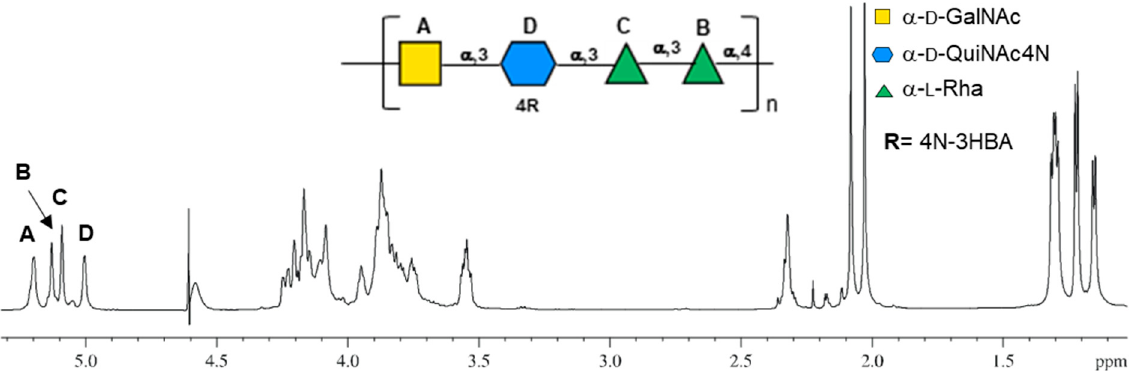
Figure 1. Proton spectrum of the O-antigen of Cupriavidus metallidurans CH34, measured at 600 MHZ at 318 K in D 2 O with its chemical structure. Letters used to mark the anomeric signals (5.3–4.9 ppm) are as in Table 1 and are reported on the structure of the linear repeating unit of the O-antigen. The structure is represented according to the symbolic nomenclature for glycans. Table 1. (600 MHz, 318 K, D 2 O) Proton and carbon chemical shift values of the O-antigen of Cupriavidus metallidurans CH34. Both galactosamine ( A ) and bacillosamine ( D ) are N ‐ acetylated ( 1 H 2.08 and 2.03 ppm, respectively, 13 C 23.7 ppm for both).